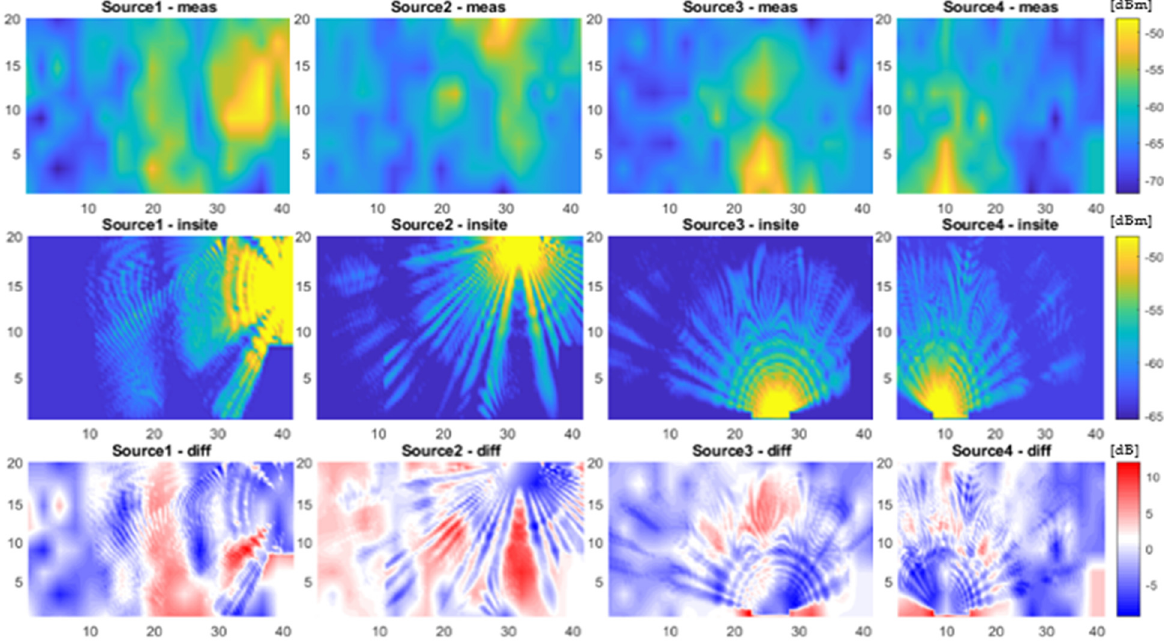
Figure 13. Comparison of reference RSSI maps created by measurements and simulations using the multiwall method. Row 1—measurement data. Row 2—distributions generated by ray tracing. Row 3 is the result of calculating the subtraction between these maps presented on the spatial